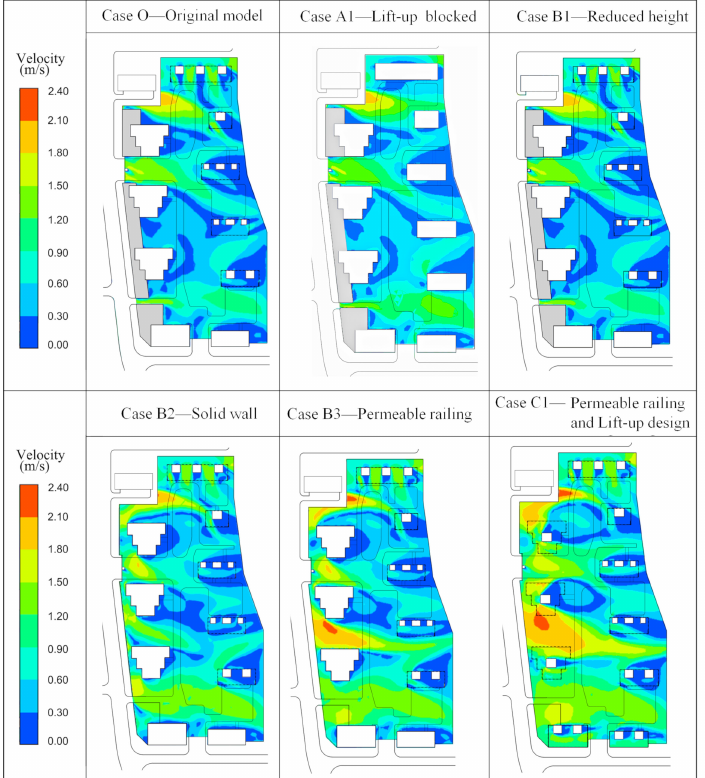
Figure 12. Wind velocity simulation results corresponding to the six